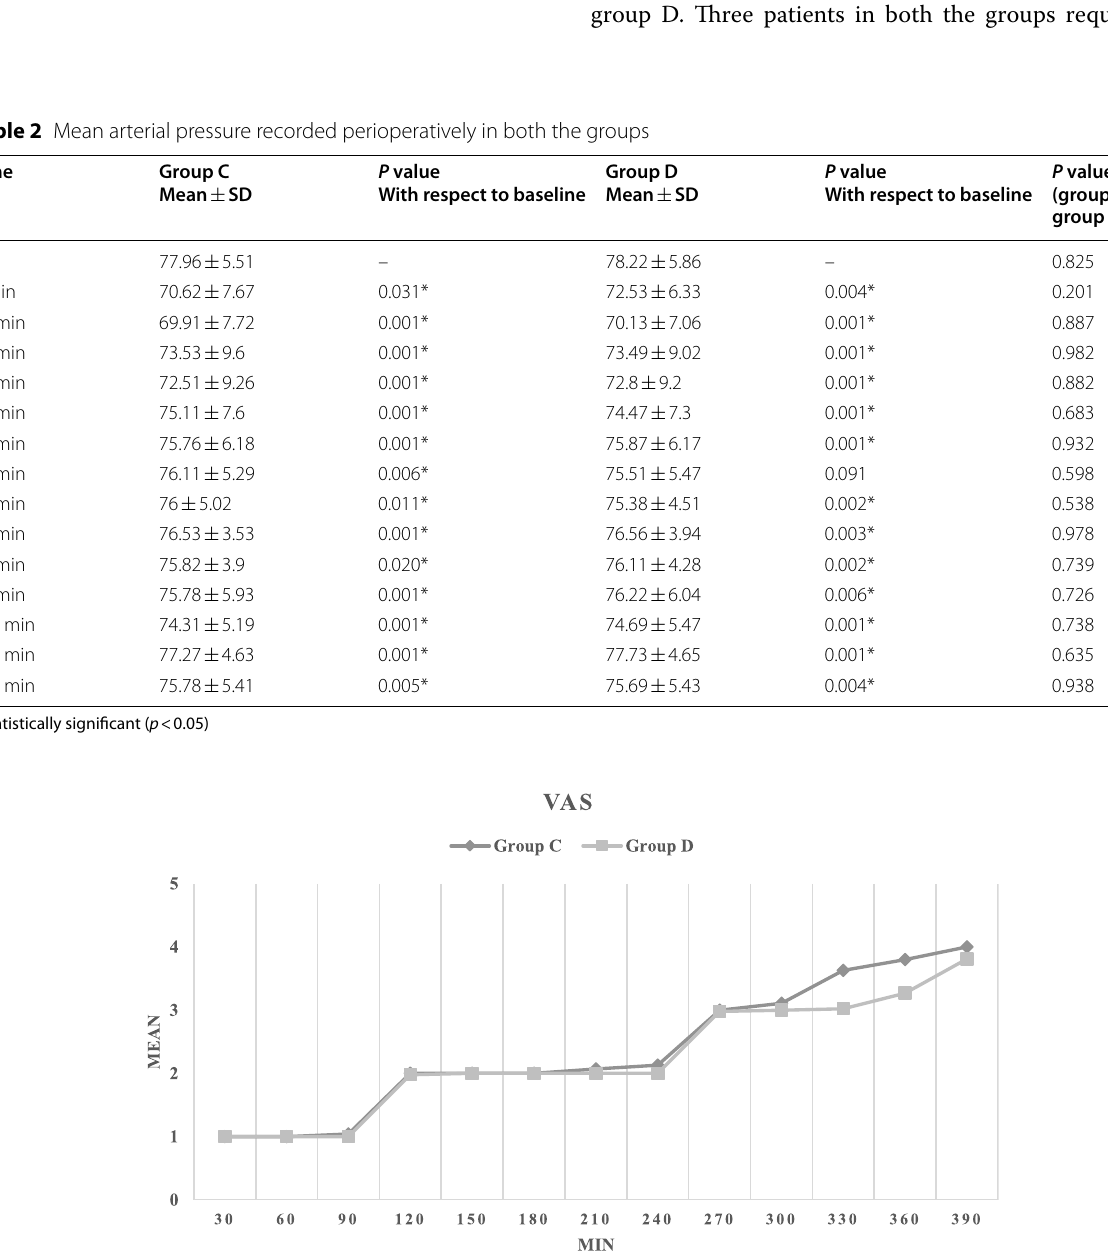
Fig. 2 Visual analogue scale (VAS score) recorded at various time interval in the two